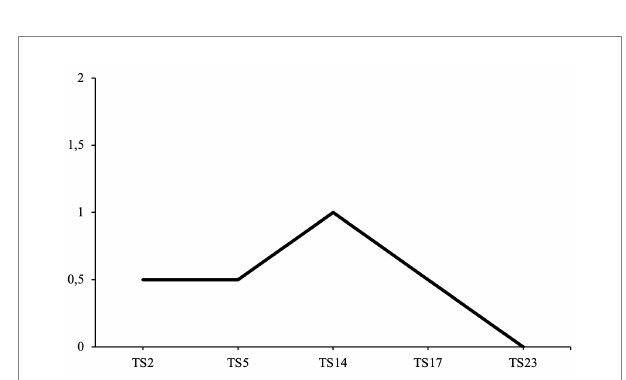
FIGURE 5 Average communion fulfillment scores over the course of treatment. TS, therapy